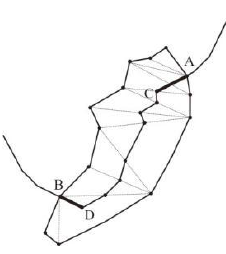
Figure 3. Central Axis Extraction for a Double-Line